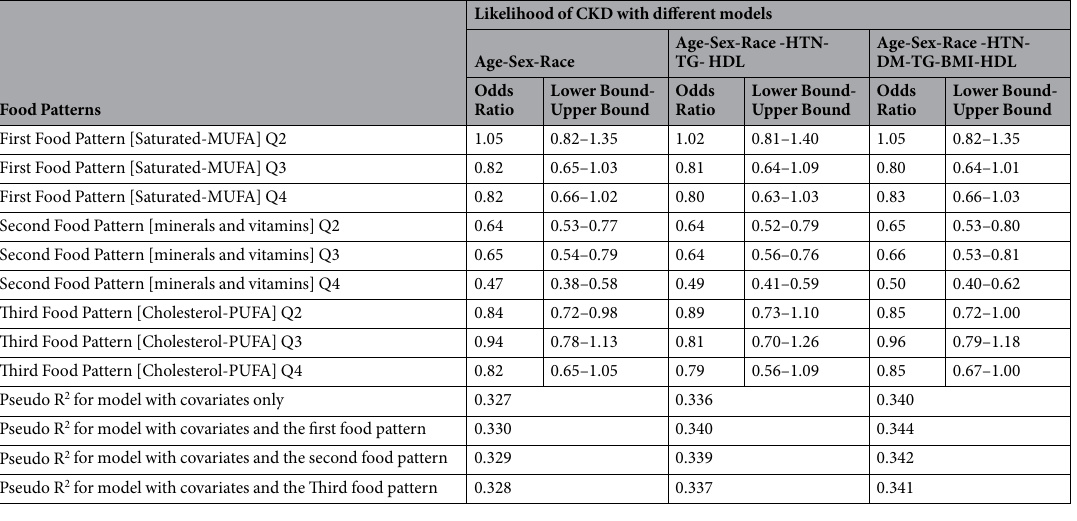
Table 2. Adjusted logistic regression to examine the association between quartile for food pattern and risk of the chronic kidney diseases. The first quarter was used as a reference for all the food patterns. BMI: body mass index, CKD: chronic kidney diseases, DM: Diabetes, HDL: High density lipoprotein, HTN: Hypertension, Q2: Second quarter, Q3: Third quarter, Q4: Fourth quarter, TG: Triglyceride. The pseudo R 2 is the Nagelkerke pseudo R 2 . Quarters were derived based on the distribution of each targeted food pattern, generating four groups with approximately equal number of